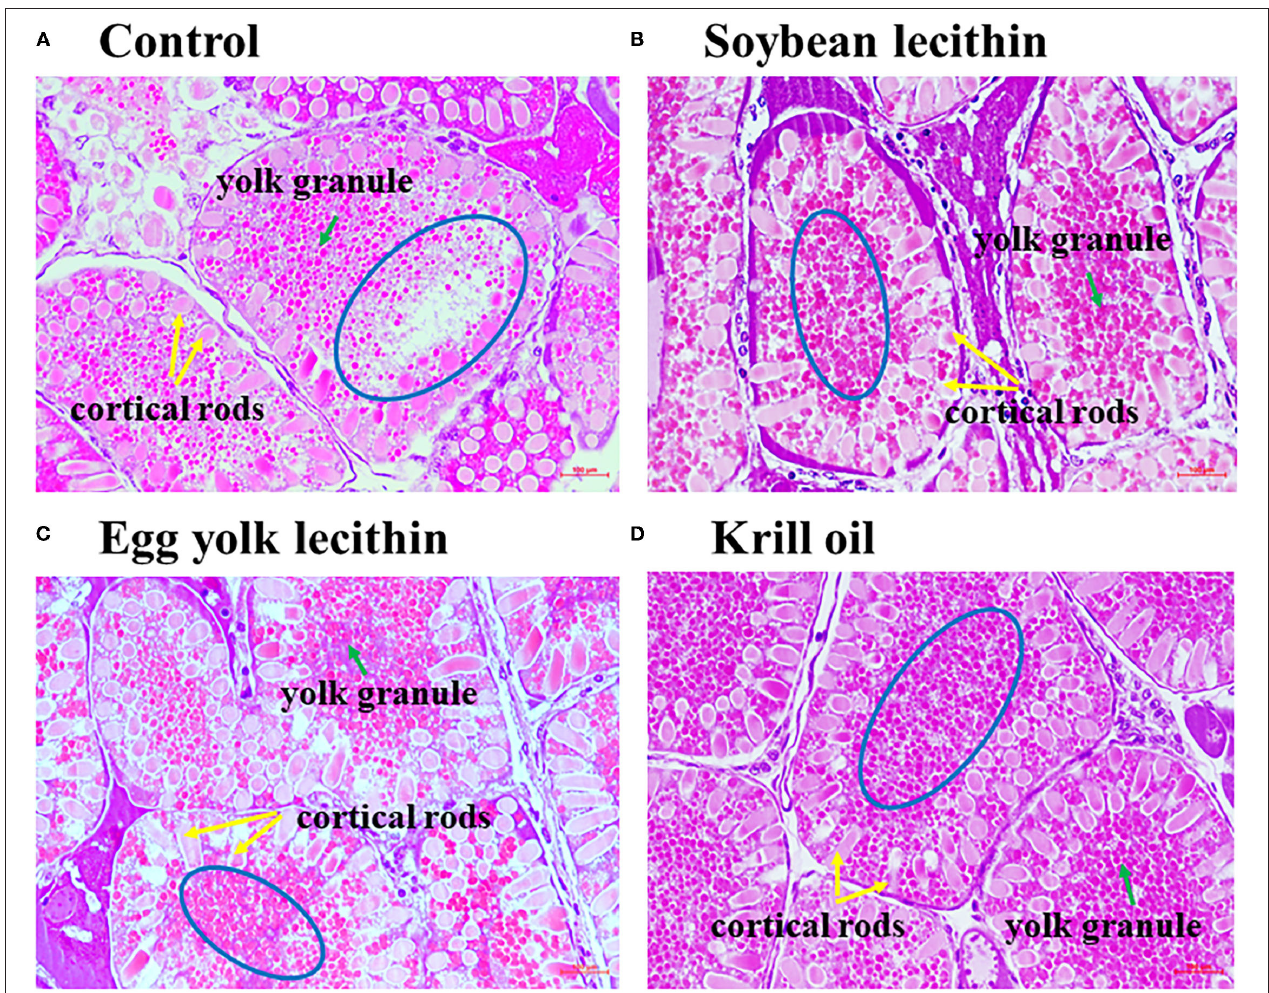
FIGURE 3 | Photomicrographs of ovaries from a shrimp exposed to different treatment diets with hematoxylin and eosin staining to show the changes in yolk granules. Ovarian histology of C. quadricarinatus fed with Control diet (A) , 4% soybean lecithin diet (B) , 4% egg yolk lecithin diet (C) or 4% krill oil experimental diet (D) . The magnification was 400 × , and the scale represents 100 µ m. The blue circle emphasizes the deposition density of yolk granules, the green arrow indicates yolk granules, and the yellow arrow indicates cortical